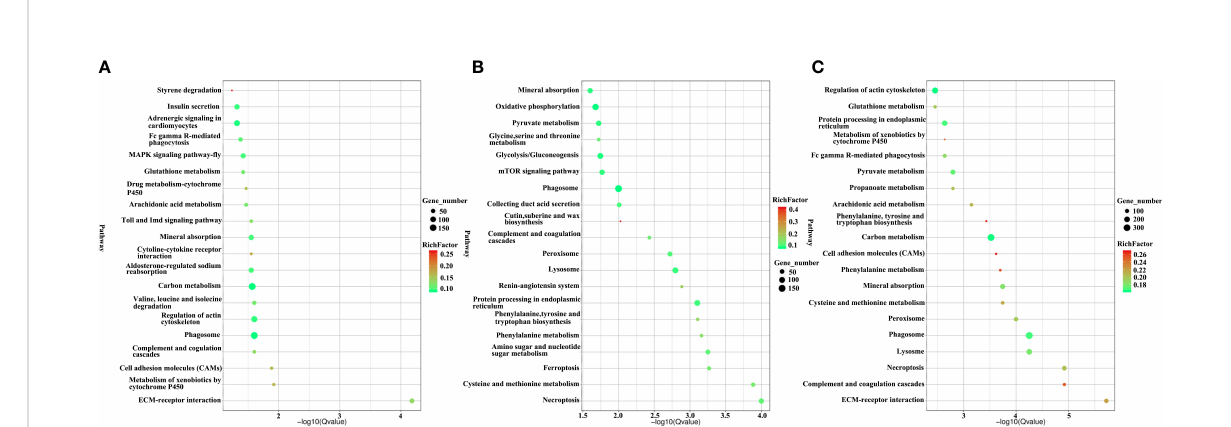
FIGURE 5 The top 20 signalling pathways of the upregulated unigenes (A) , downregulated unigenes (B) , and total DEUs (C) related to H. eriocheir infection in E. sinensis intestine based on KEGG enrichment